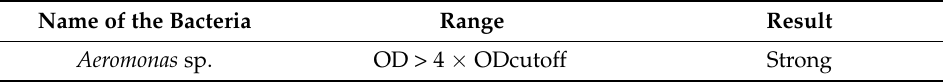
Table 2. The biofilm formation efficacy of Aeromonas